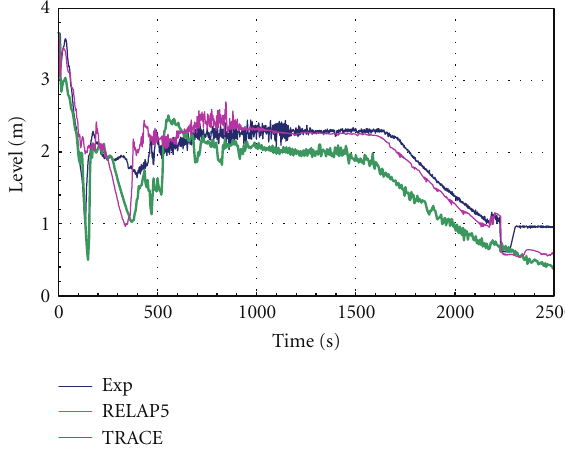
Figure 9: Secondary pressure.